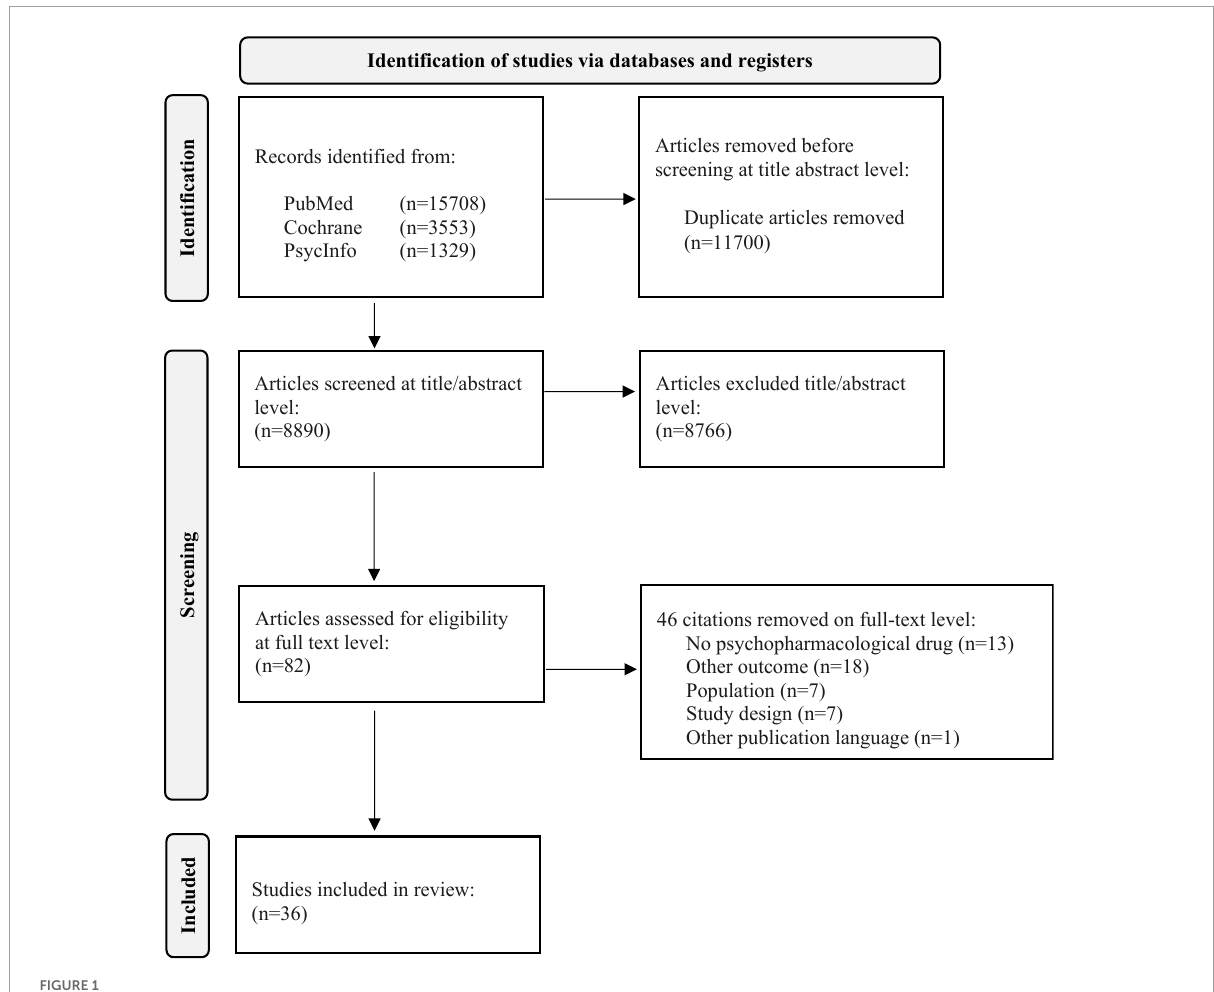
FIGURE1 PRISMA flow diagram of included